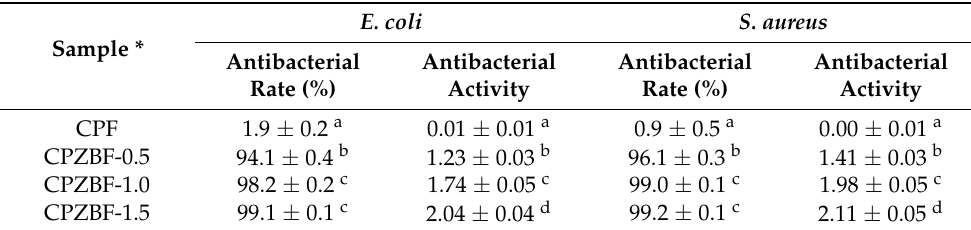
Table 4. Antibacterial rate and activity of the crosslinked pectin/ZnO bionanocomposite films (CPZBF) against E. coli and S. aureus